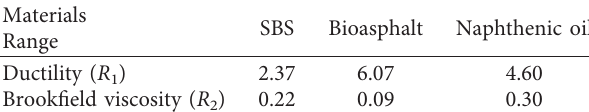
Table 4: Correlation and range analysis.